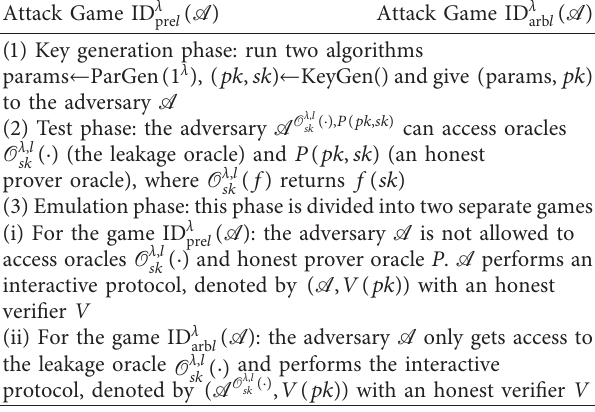
Table 1: Attack game for defining the pre-emulation leakage se- curity and arbitrary time leakage security of ID λ ( A ) , ID λ arb l